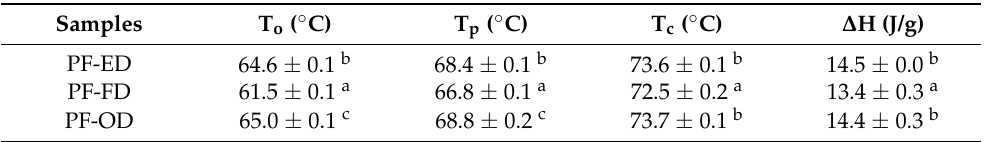
Table 2. Thermal properties (measured by DSC) of potato flours.